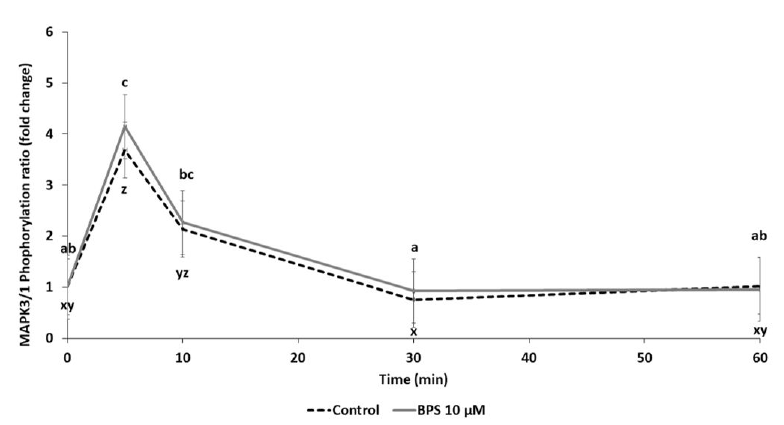
Figure 7. Western blot analysis of MAPK3 / 1 signalling pathway activation in human granulosa cell (HGC) after Bisphenol S (BPS) exposure. HGC underwent a time response (0 to 60 min culture) in the presence or absence of BPS 10 µ M. Proteins were then extracted and separated using electrophoresis in 4–12% ( w / v ) sodium dodecyl sulphate polyacrylamide gels. After electrotransfer to nitrocellulose membranes, the proteins were probed with phospho-MAPK3 / 1 and total MAPK3 / 1 antibodies. Bands on the blots were quantified, and the data are expressed in arbitrary units as the ratio of phospho- to total MAPK3 / 1 as the mean ± standard error of the mean (SEM) of six independent experiments. Di ff erent letters indicate significant di ff erences ( p ≤ 0.05). abc letters correspond to di ff erences in MAPK3 / 1 phosphorylation between 10 µ M BPS timepoints, and xyz letters correspond to di ff erences in MAPK3 / 1 phosphorylation between control timepoints.